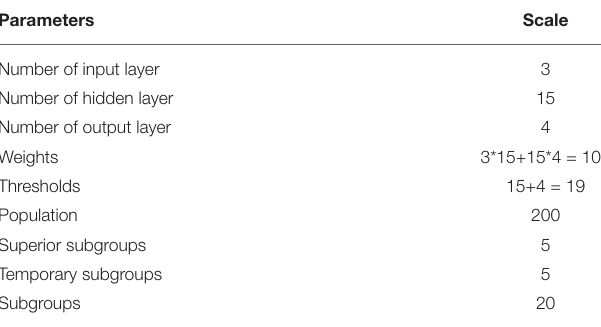
TABLE 2 | Parameters of the CNV-MEANN